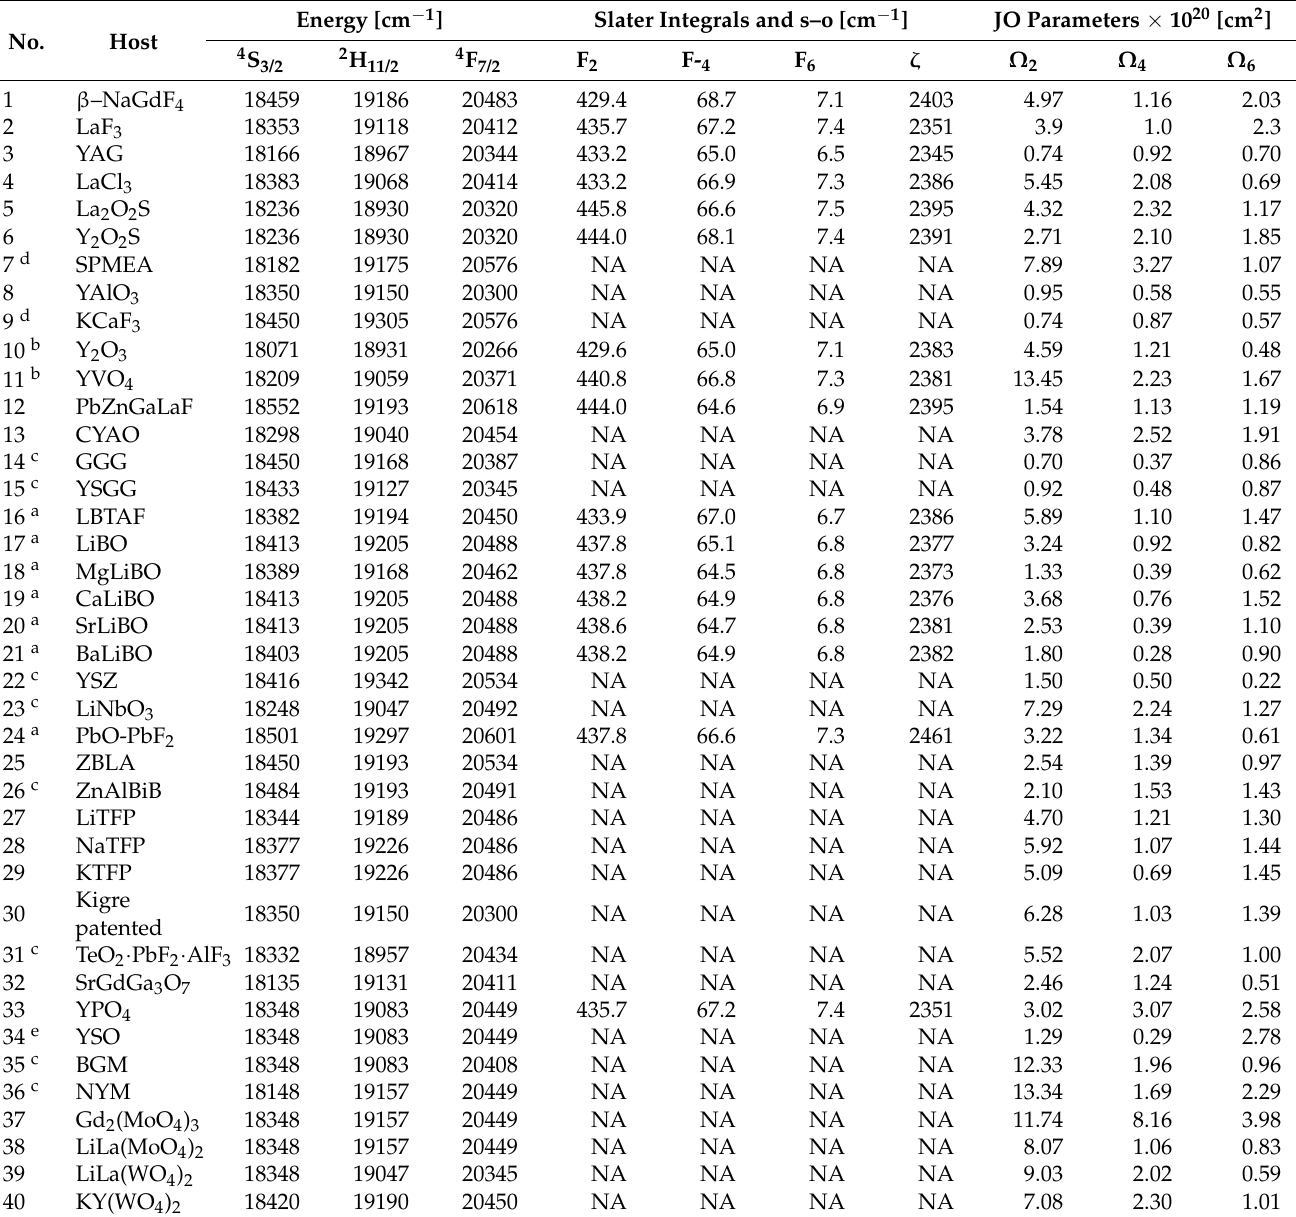
Table 2. Energies of 4 S 3/2 , 2 H 11/2 and 4 F 7/2 levels in hosts listed in Table 1, their Slater integrals and spin-orbit (s–o) coupling parameters, and JO intensity parameters as reported in the corresponding